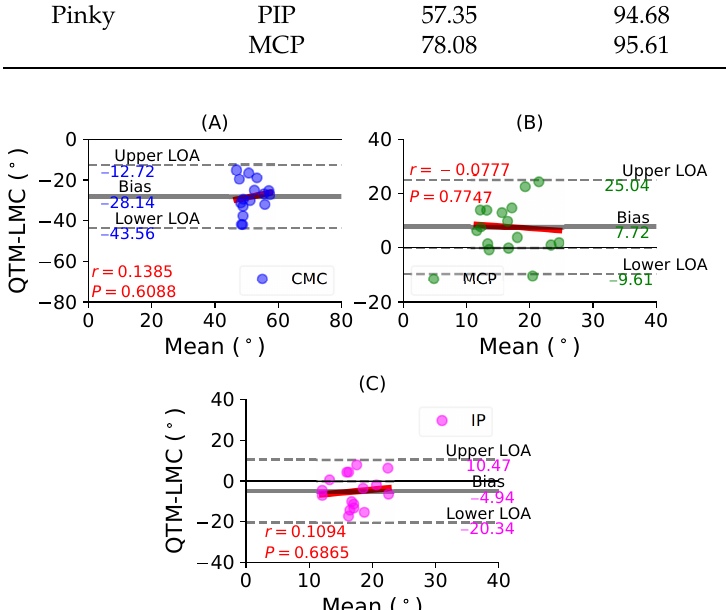
Figure 5. A BA plot of thumb abduction. ( A ) CMC joint, ( B ) MCP joint and ( C ) IP joint. Figure 6A shows a BA plot for the CMC joint with a negative bias of 31.31 ◦ with r = 0.0084, P = 0.9735. Figure 6B shows a positive bias of 9.19 ◦ with r = 0.6381, P = 0.0043 for the MCP joint. Lastly, Figure 6C shows a positive bias of 2.01 ◦ with r = 0.3219, P = 0.1926 for the IP joint. During the thumb flexion movement, only the flexion of the MP joint demonstrated the highest correlation significance between the QTM and LMC measuring systems. However, the CMC joint showed the least